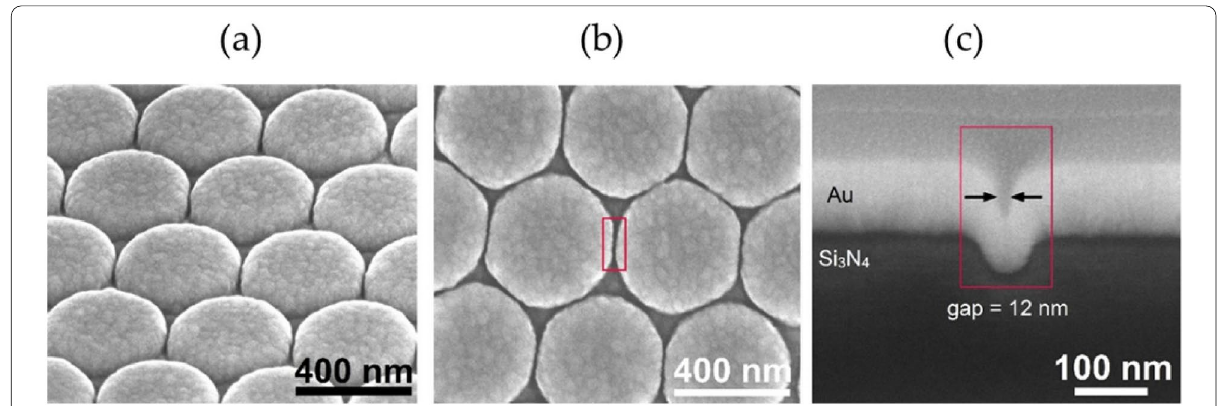
Fig. 12 Scanning electron microscope images of gold nanodomes. a Tilted view. b Top-down view. c Cross-section of a nanodome-patterned chip with a 12 nm wide gap between nanodomes. (Reprinted with permission from Ref. [62])